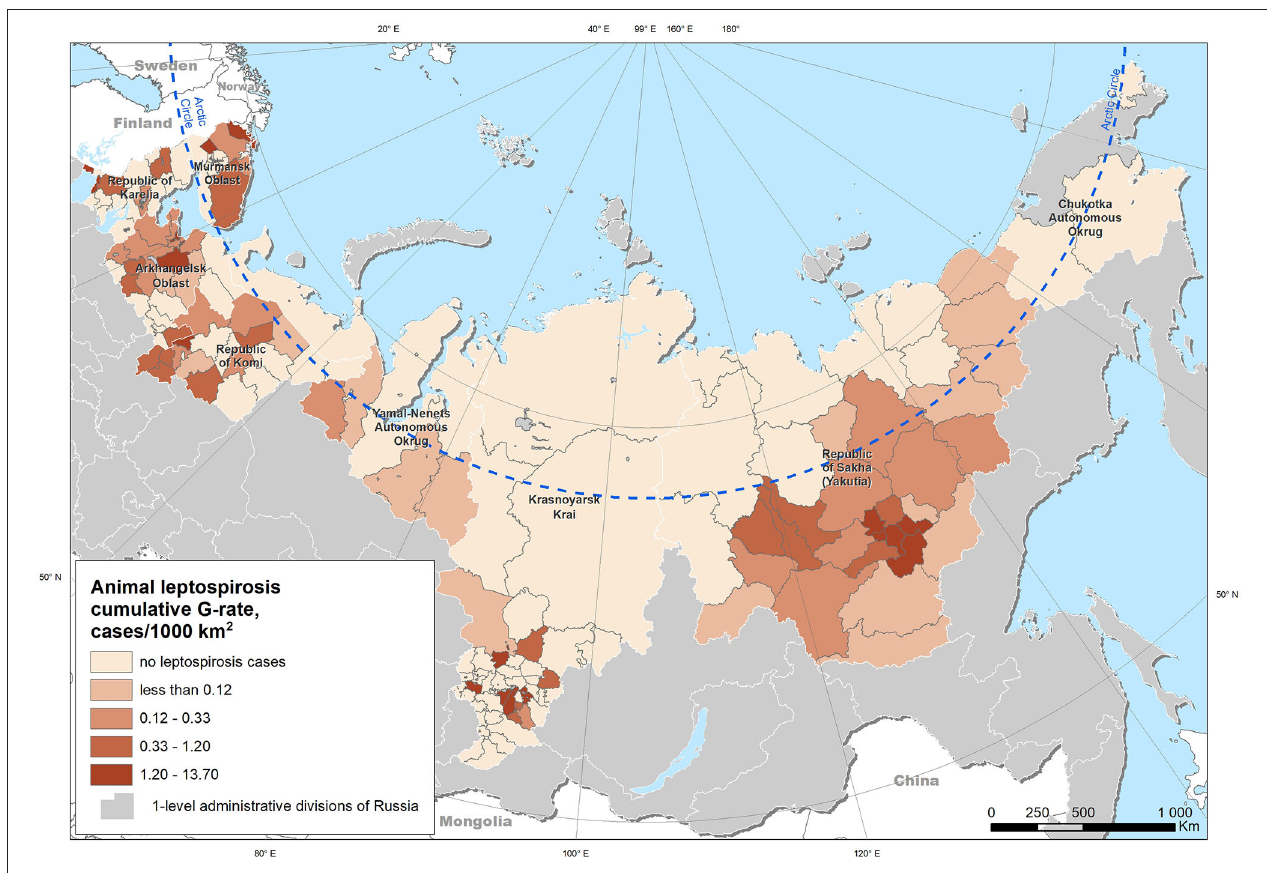
FIGURE 1 | Study area and cumulative leptospirosis G-rate in livestock (cases per 1,000 km 2 ) for the period from 2000 to